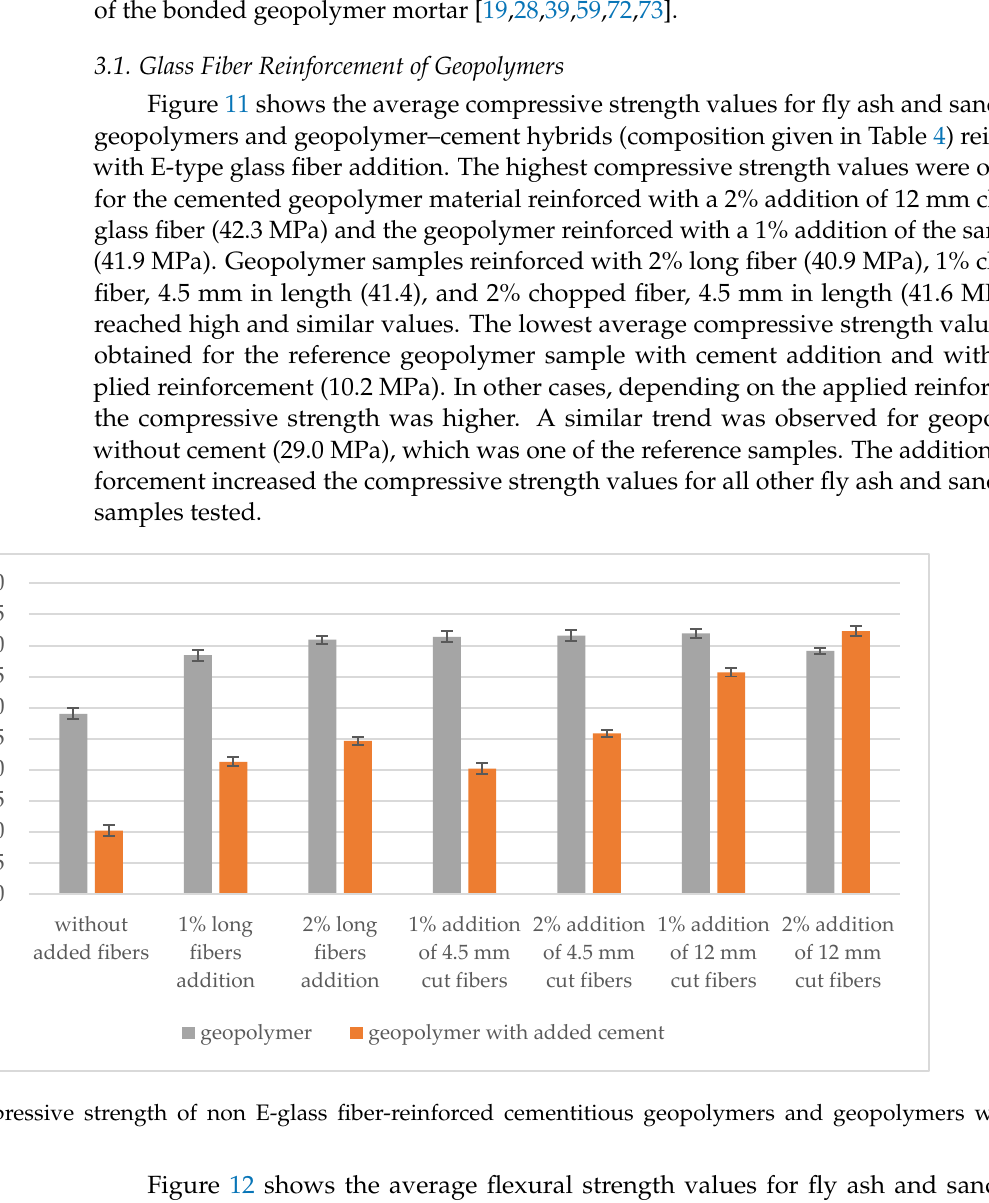
Figure 12. Flexural strength of E-glass fiber-reinforced geopolymers and geopolymers with cement addition. As a result of the tests, it was observed that the best compressive strength results for specimens with the addition of E-type glass fibers were obtained for geopolymer – cement